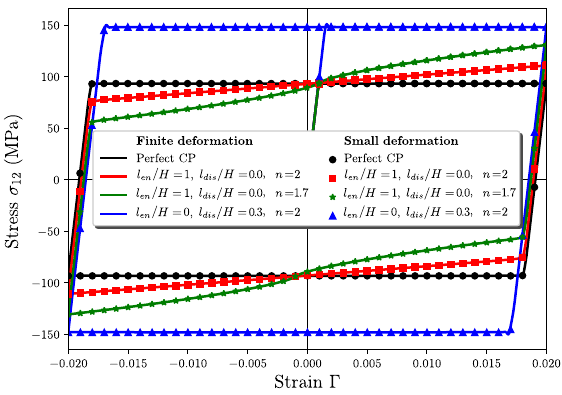
Figure 3. Small shear loading results for different energetic and dissipative parameters: comparison between the small and finite deformation models (small deformation results are taken from [34]).